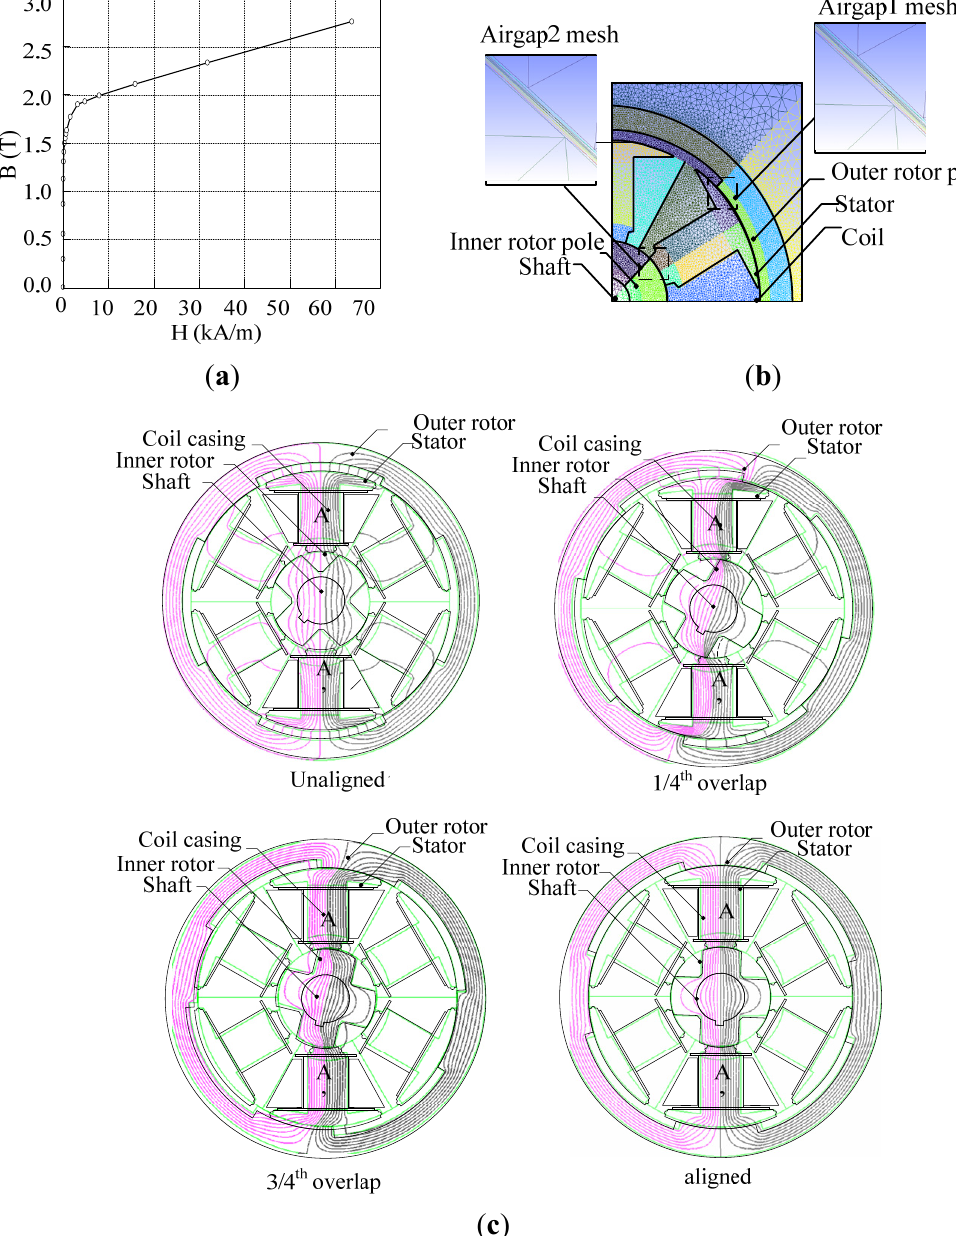
Figure 8. FEM flux flow pattern ( a ) BH curve for the material used; ( b ) FEM Discretization; ( c ) Flux flow at different aligned